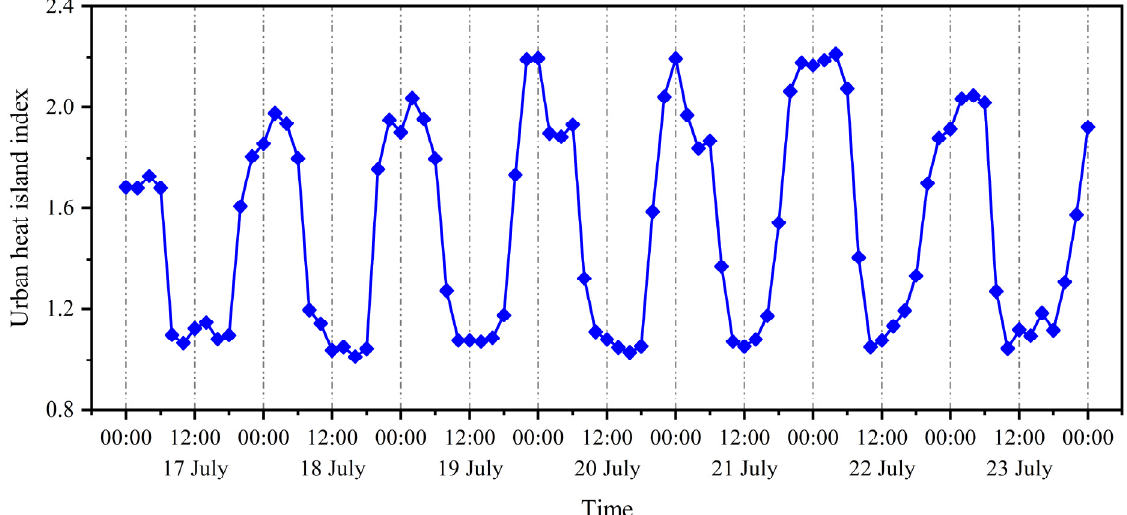
Figure 4. UHI index of the city of Wuhan in the summer of 2018.